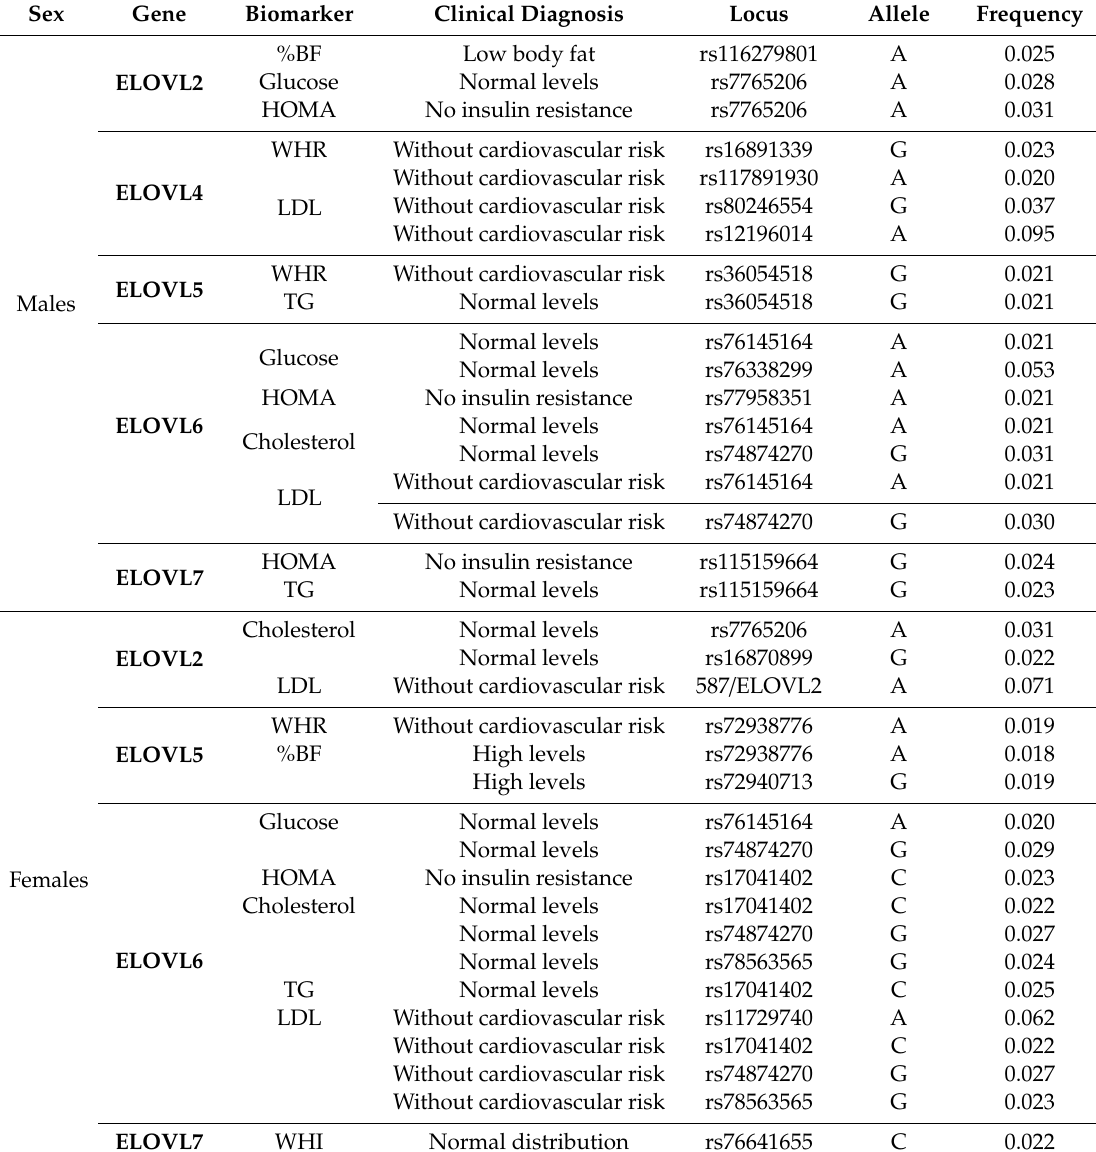
Table 3. Single Nucleotide Polymorphisms private alleles with significant associations with biomarkers.